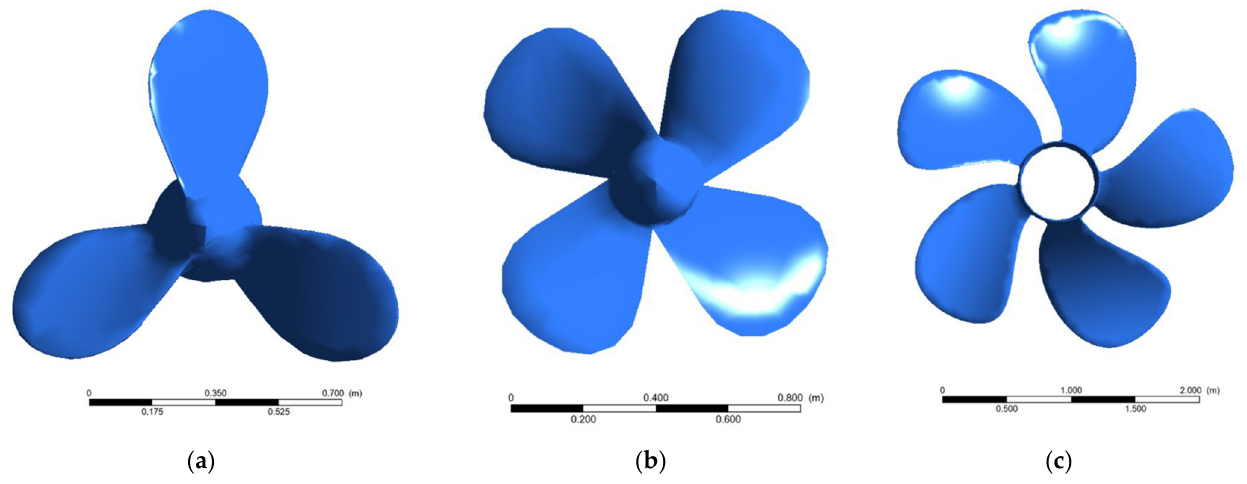
Figure 1. Topology of fixed-screw-angle marine propellers: ( a ) 3 blades; ( b ) 4 blades; and ( c ) 5 blades.